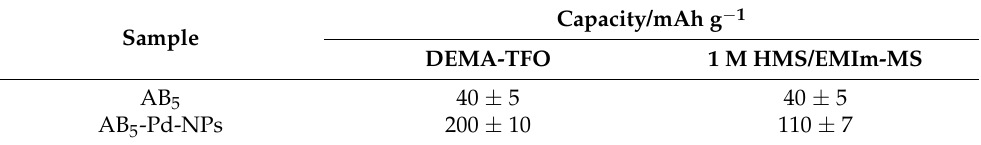
Table 3. Hydrogen absorption capacities calculated from chronopotentiometric discharging.